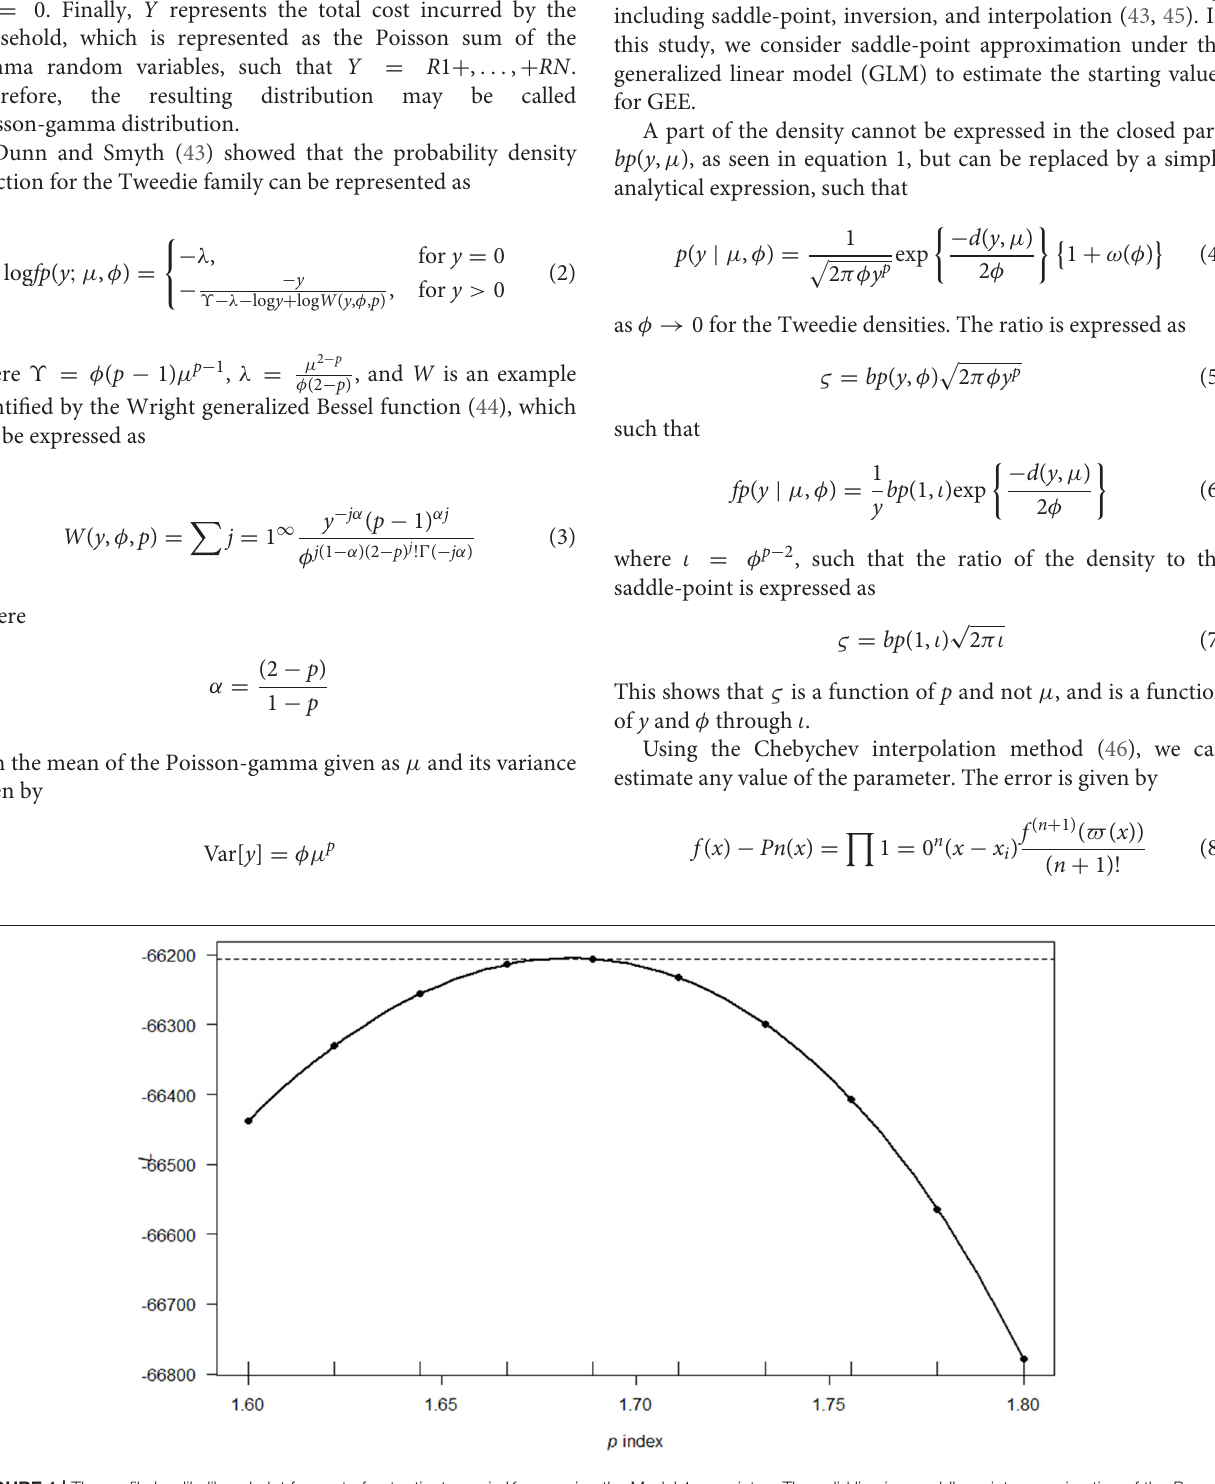
Frontiers in Public Health |